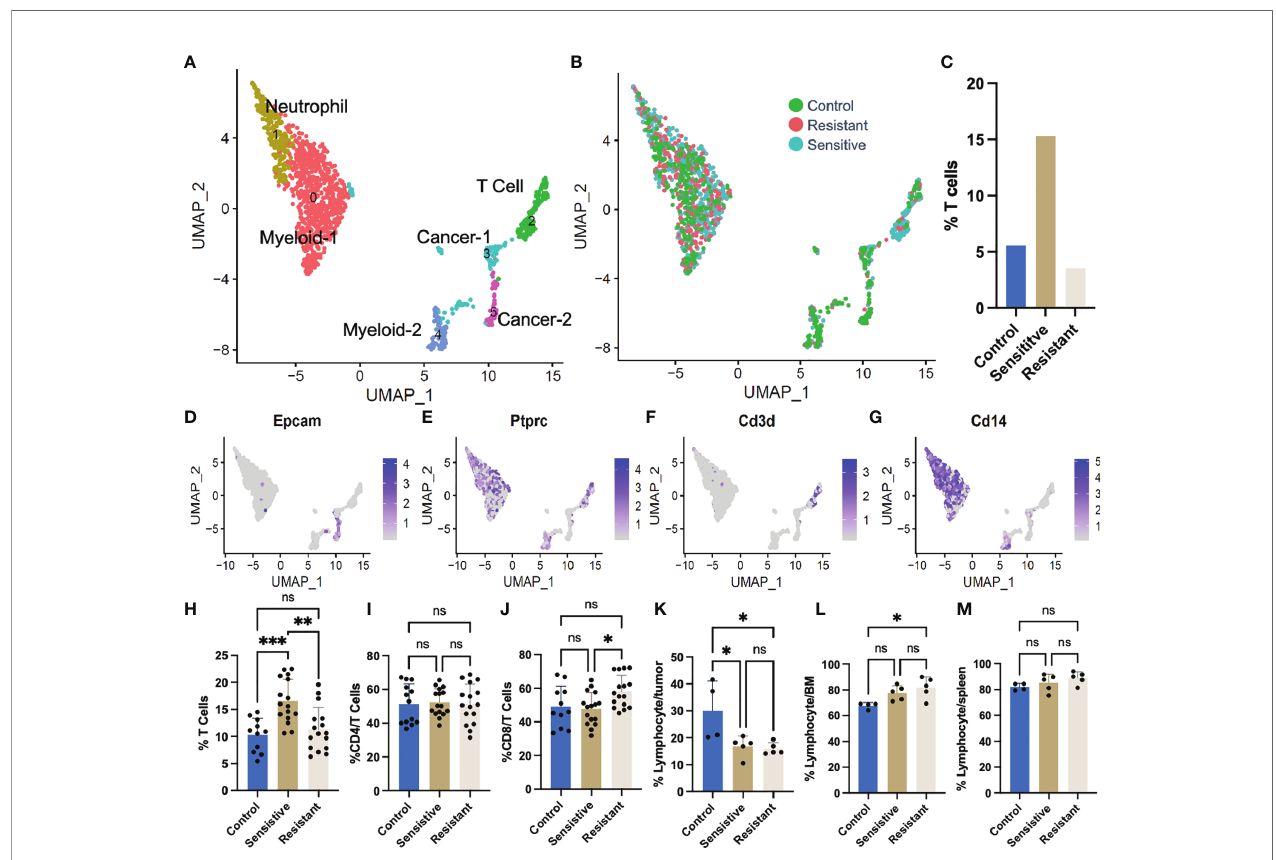
FIGURE 2 | Single cell RNA sequencing (scRNA-Seq) of tumors following DOX administration. (A) UMAP plot representing all tumor cells following DOX treatment. (B) Colors depict cells derived from tumors of different treatment/response. (C) T cell [Ptprc (CD45)+ CD3d+] relative abundance derived from single cell RNAseq data. (D – G) Feature plots of gene markers used in identifying cell clusters. (H) Flow cytometric quanti fi cation of T cell (CD3 ϵ +) abundance in syngeneic 4T1 tumors. (I) Flow cytometric quanti fi cation of cytotoxic T cell (CD8+CD3 ϵ +) abundance in syngeneic 4T1 tumors. (J) Flow cytometric quanti fi cation of immune [Ptprc (CD45)+] abundance in syngeneic 4T1 tumors. (K) Flow cytometric quanti fi cation of immune [Ptprc (CD45)+] abundance in bone marrow of tumor bearing mice. (L) Flow cytometric quanti fi cation of immune [Ptprc (CD45)+] abundance in spleens of tumor bearing mice. (M) Flow cytometric quanti fi cation of immune [Ptprc (CD45)+] abundance in spleens of tumor bearing mice. ns: non-signi fi cant p > 0.05; * p ≤ 0.05; ** p ≤ 0.01; *** p ≤